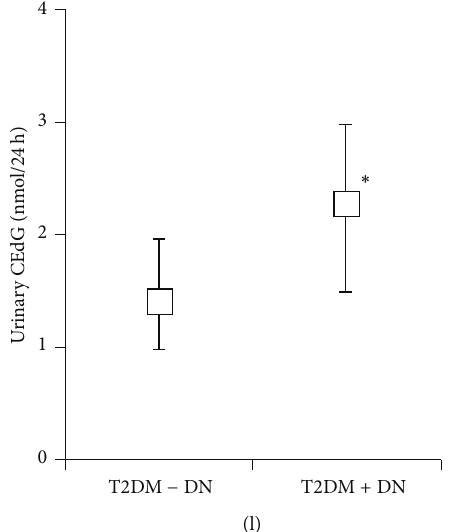
Figure 1: (a) Formation of glycation and oxidation adducts of deoxyguanosine. The common 2 󸀠 -deoxyribosyl group has been omitted for clarity. (b)–(i) Nucleotide glycation and oxidation adducts in plasma and urine of healthy controls subjects and patients with type 2 diabetes. Plasma:(b)GdG,(c)MGdG,(d)CEdG,and(e)8-OxodG.Urine:(f)GdG,(g)MGdG,(h)CEdG,and(i)8-OxodG.(j)–(l)Nucleotideglycation and oxidation adducts in plasma and urine in patients with type 2 diabetes with and without nephropathy. (j) Plasma 8-OxodG, (k) urinary GdG, and (l) urinary CE-dG. Data are median with the upper and lower quartile as error bars. Significance: ∗ 𝑃 < 0.05 , ∗∗ 𝑃 < 0.01 , and ∗∗∗ 𝑃 < 0.001 ; Mann-Whitney 𝑈